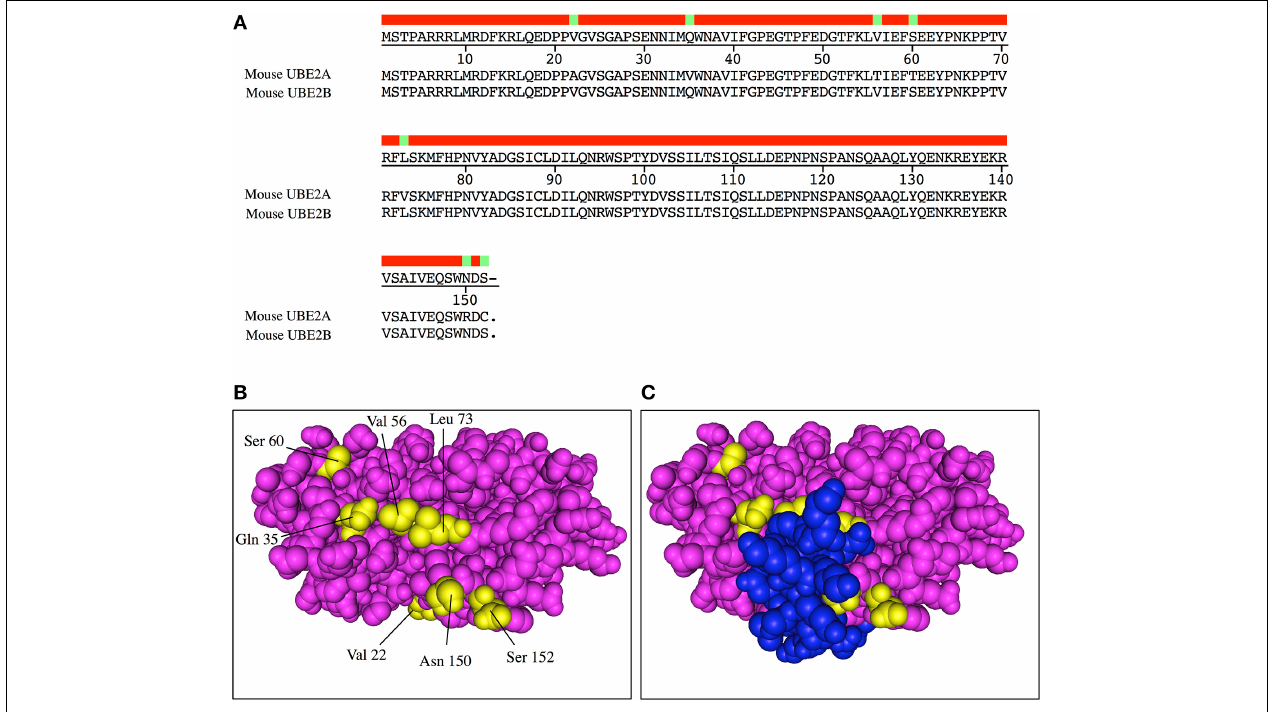
FIGURE 1 | Crystallographic structure of human UBE2B. (A) Alignment of mammalian UBE2A and UBE2B. Consensus sequence (red bar) is shown at the top and differential residues are highlighted in green. (B) UBE2B structure backside view (PDB code 2YBF). Specific residues within